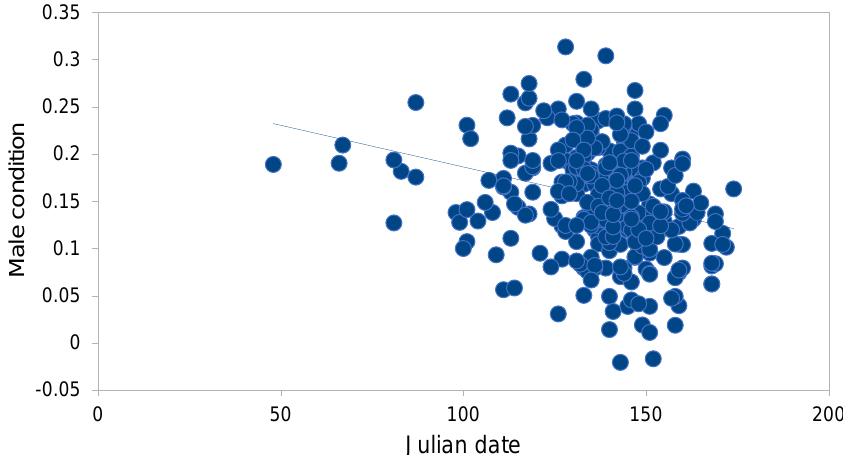
Figure 4. Relationship between Julian date and male body condition of breeding Tawny Owls Strix